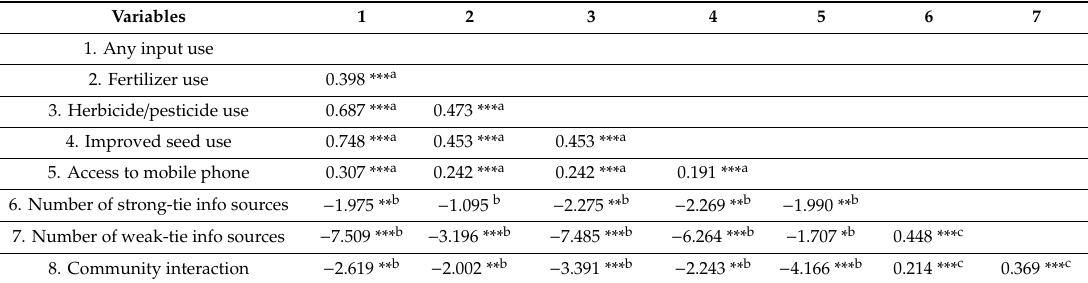
Table 1. Bivariate correlations between major